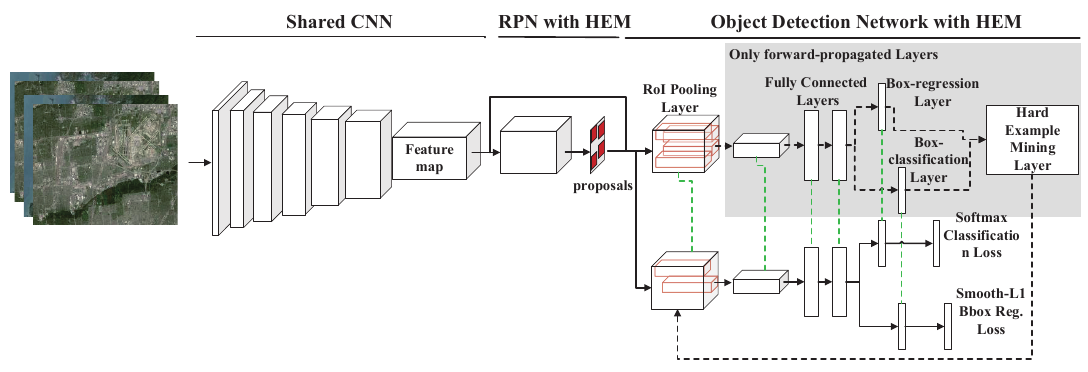
Figure 4. The framework of the Object Detection Network with hard example mining. The dark dotted line indicates that the data is only delivered in single direction along the arrow. In addition, loss-signals are not backward propagated along the dotted line. The network parameters are shared between the layers connected with a green dotted